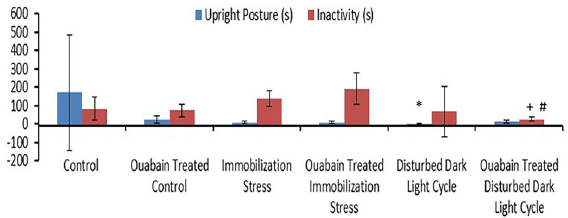
Figure 2. Total duration of upright posture (s) and inactivity (s) in the different study groups. Data are reported as means ± SD. *P o 0.05 compared to the control group; + P o 0.05 compared to the untreated immobilization group; # P o 0.05 compared to untreated rats exposed to disturbed dark/light cycle (Kruskal- Wallis